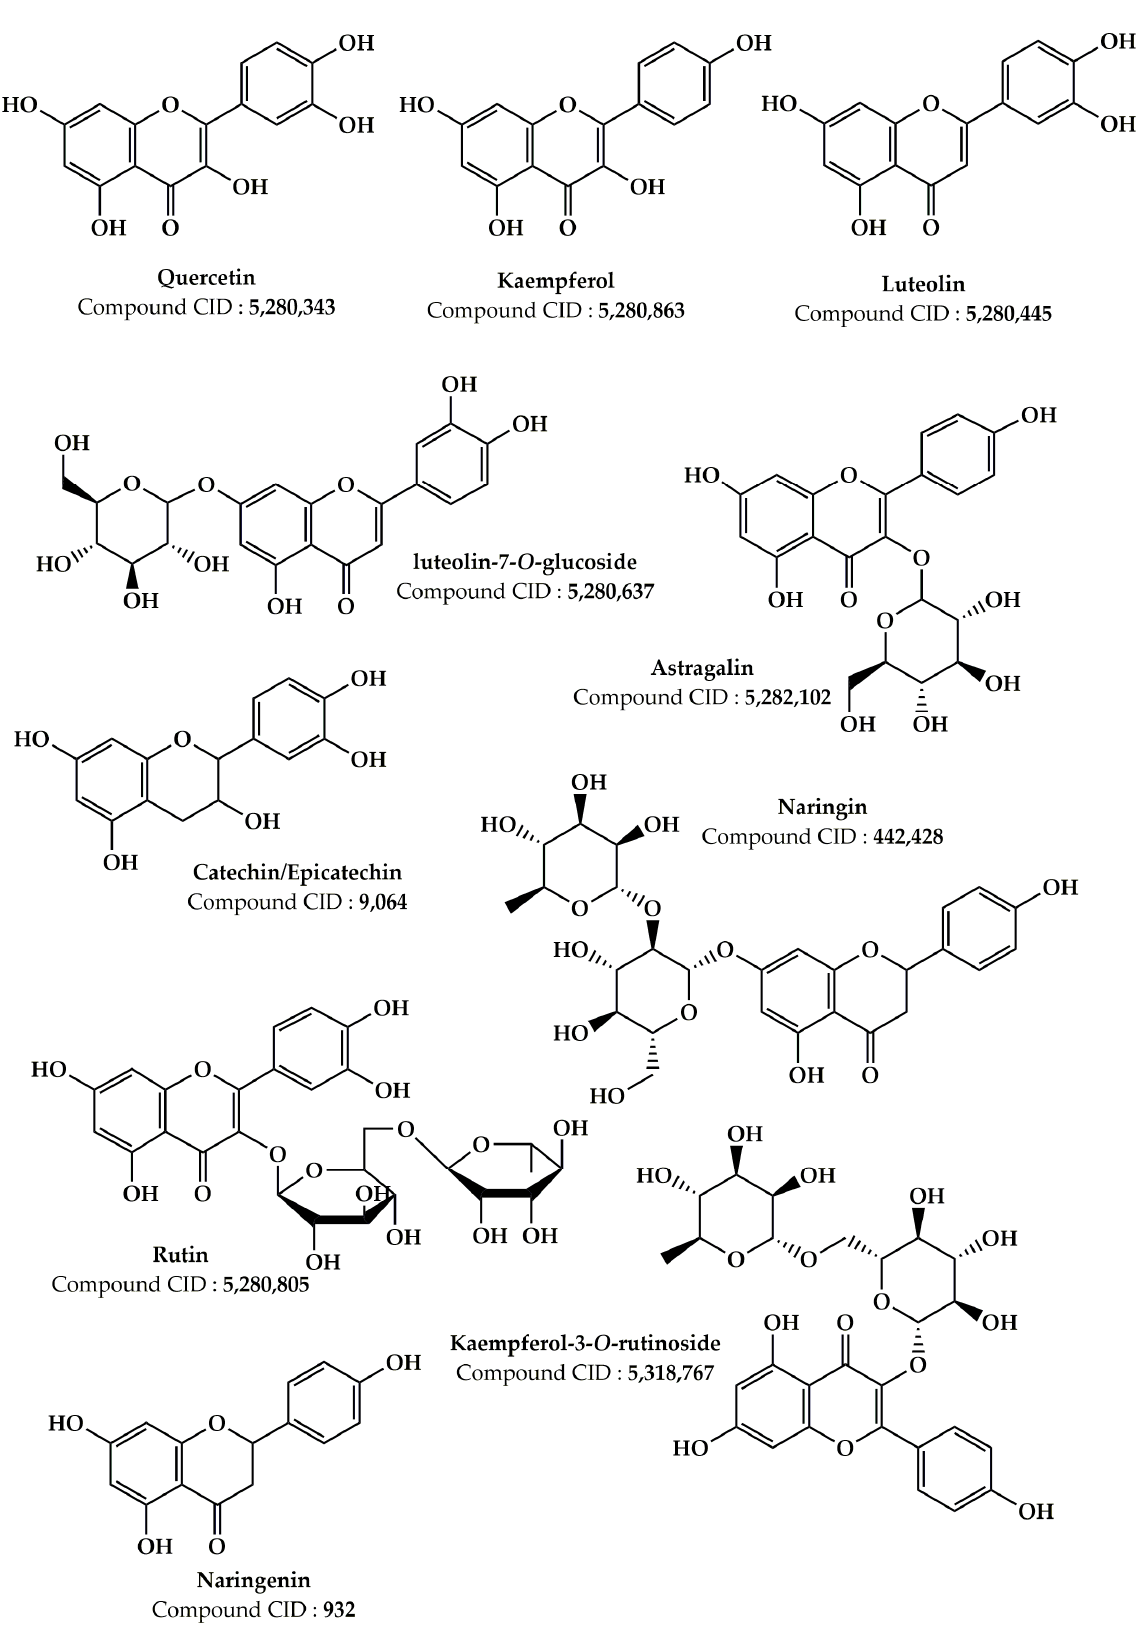
Figure 3. Chemical structures of the main fl avonoid compounds found in the Z. lotus extracts.